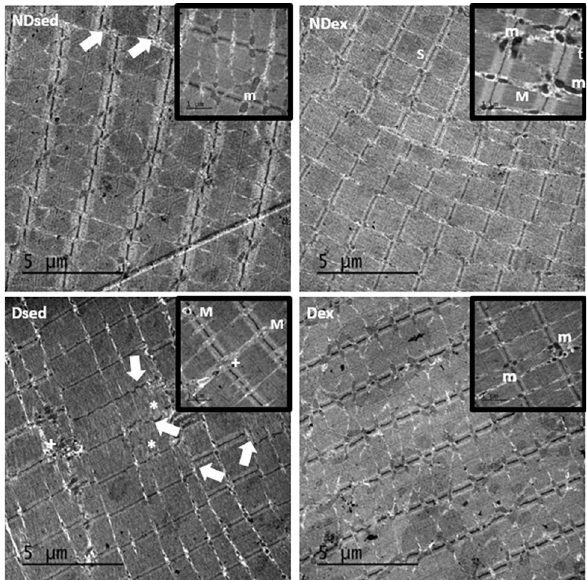
Figure 4. Electron micrographs of rectus abdominis muscle (RAM). Samples of RAM were obtained from non-diabetic sedentary (NDsed), non-diabetic exercised (NDex), diabetic sedentary (Dsed), and diabetic exercised (Dex) rats. Magnifications (20.000 x) show a detailled area of the micrograph. The micrographs show disorganized Z lines (white arrows), sarcomeres disruption areas (asterisk), intermyofibrillar mitochondria (m), myelin figures (M), organized triads (t) and an increase in collagen deposition ( +). Scale bar: 5